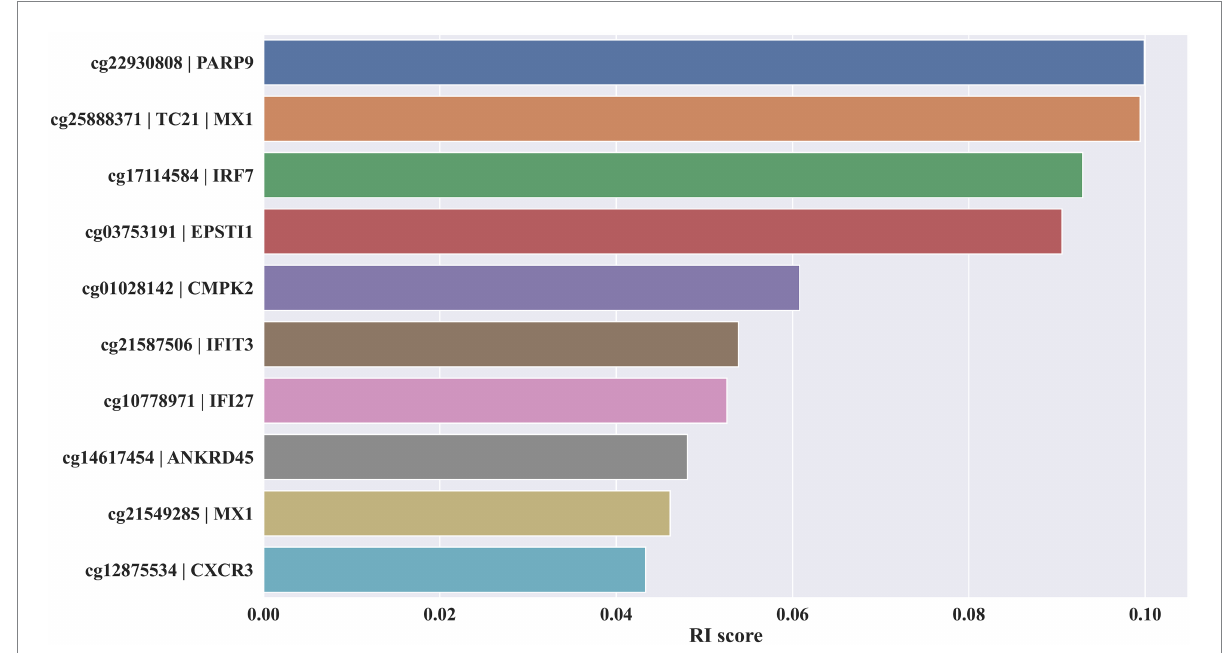
FIGURE 2 Bar chart to show top 10 key methylation features and their relative importance